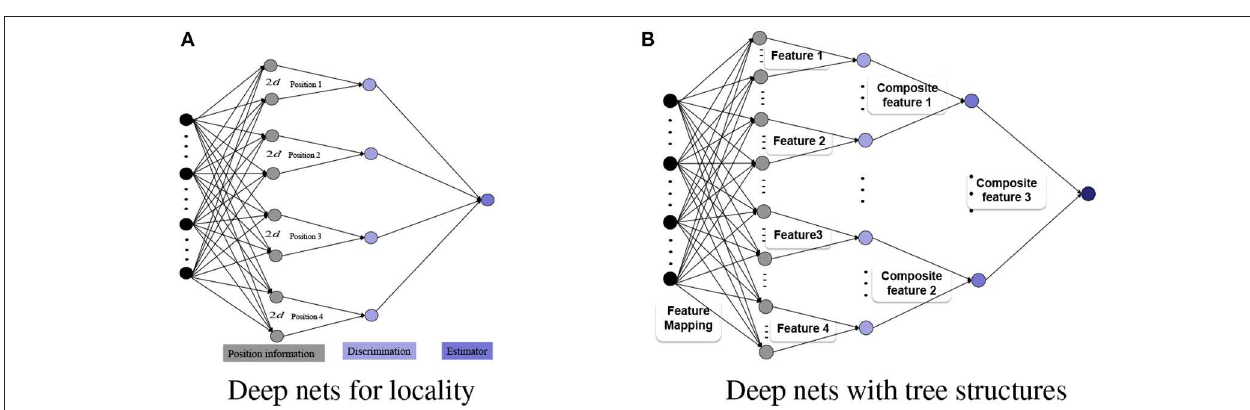
FIGURE 2 | Structures for deep nets. (A) Deep fully-connected nets. (B) Convolutional neural networks.